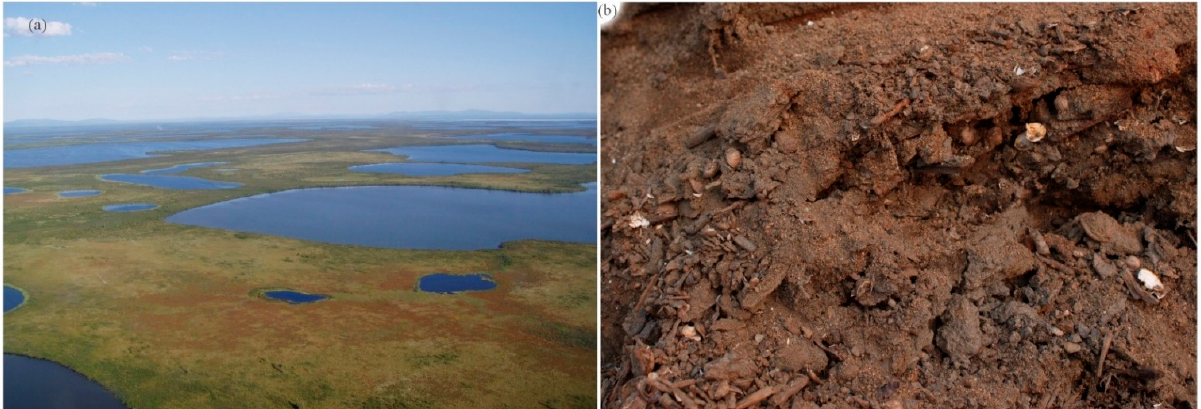
Figure 3. Lacustrine deposit. Sedimentation with local water invertebrates: ( a ) middle size tundra lakes, Old Crow Flat; ( b ) Ulakhan-Sullar deposit with shells.